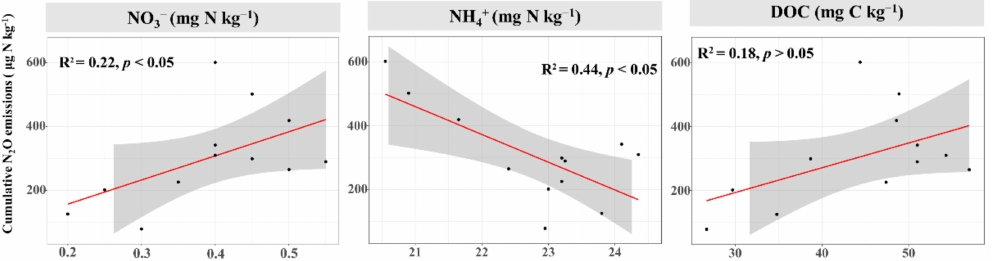
Figure 4. Relationship between cumulative N 2 O emissions and environmental variables (NO 3 − , NH 4 + , and DOC